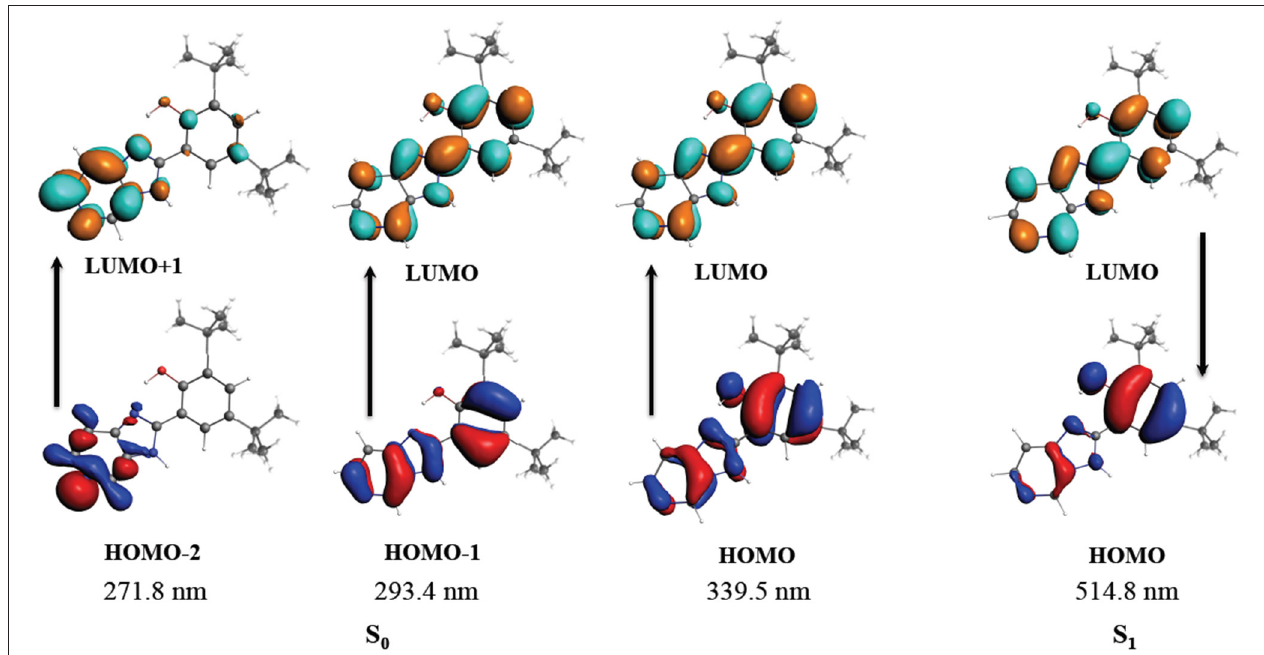
FIGURE 1 | Molecular orbitals involved in the absorption and emission for B2 . S 0 corresponds to the ground state. S 1 corresponds to the first excited singlet state.